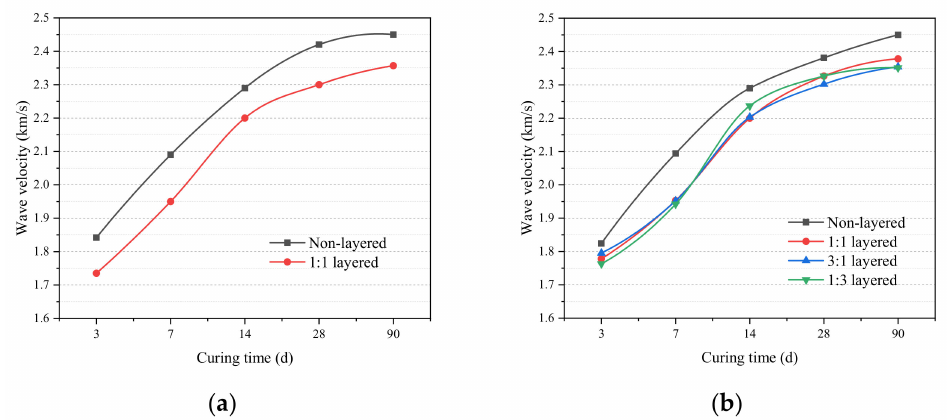
Figure 8. Variation diagram of wave velocity under the influence of curing time and different layered structures. ( a ) Content of FA is 7.5%; ( b ) Content of FA is 15%. To sum up, measured values of wave velocities of ASPLB with different ratios have little change under the same curing time. With the increase in curing time, the porosity of the backfill decreases, the degree of material bonding becomes closer and the wave velocity presents an increasing trend. The wave velocities of the LB are all lower than those of the